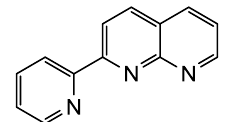
Figure 1. Chemical structure of pynp.